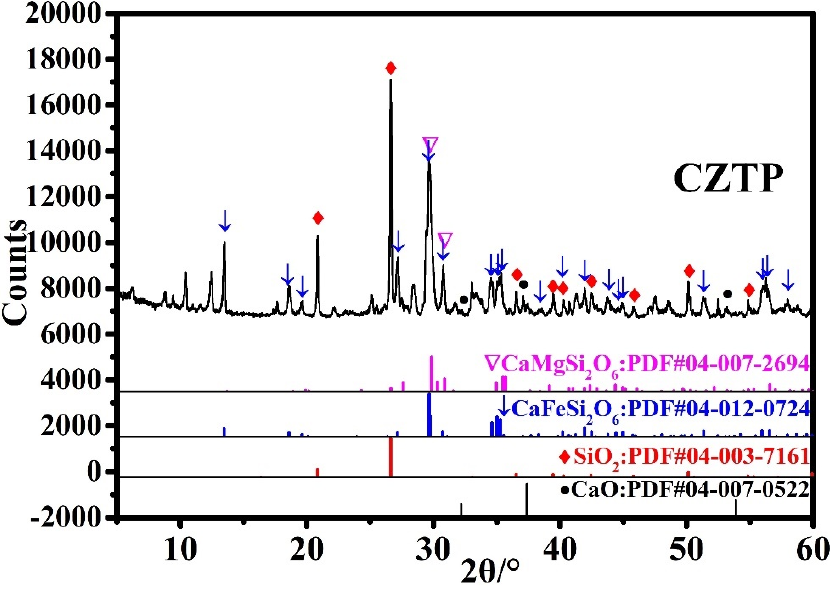
Table 1. Chemical composition of unmodified and modified copper and zinc tailing powder (wt.%).